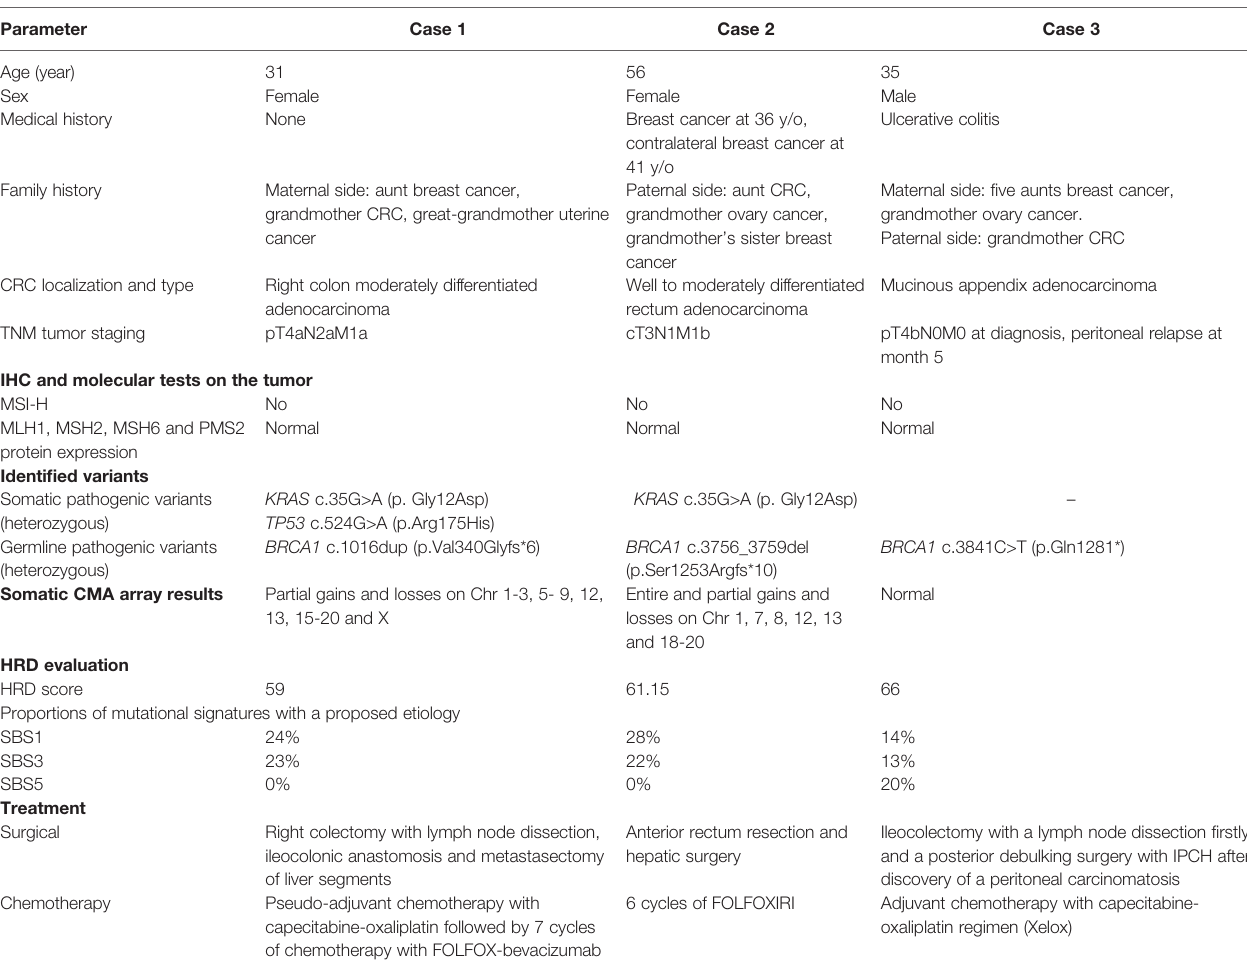
TABLE 1 | Patient